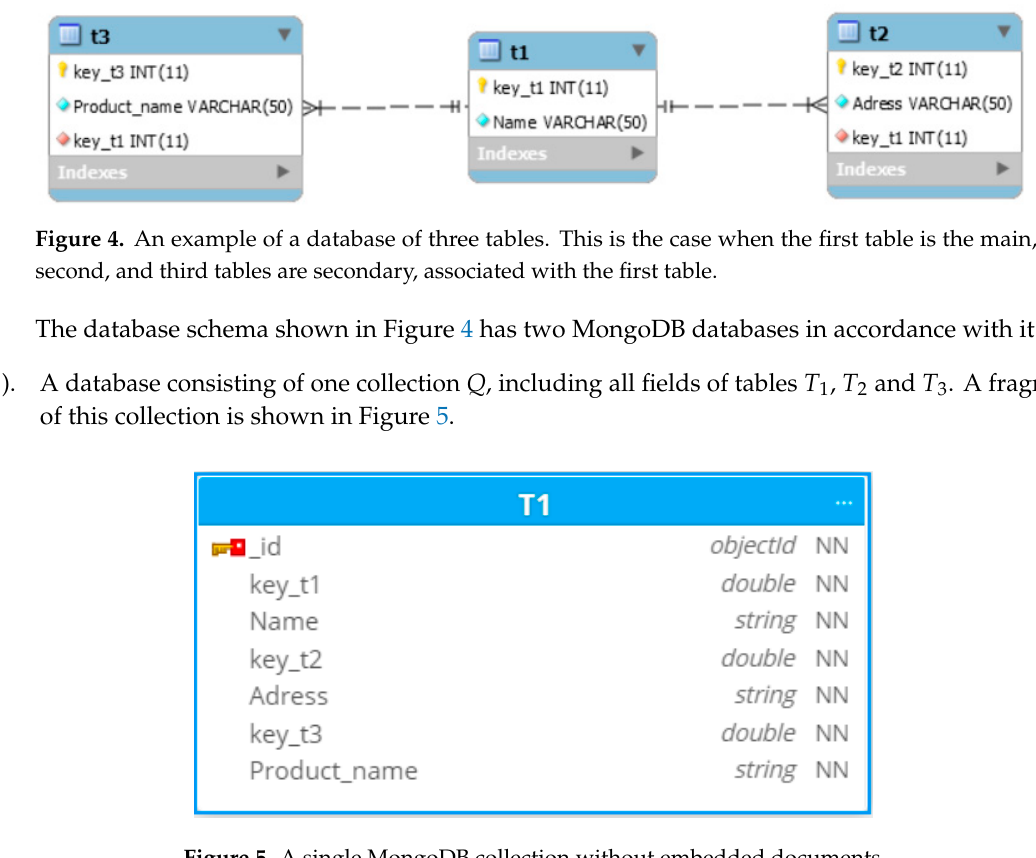
Figure 5. A single MongoDB collection without embedded documents.